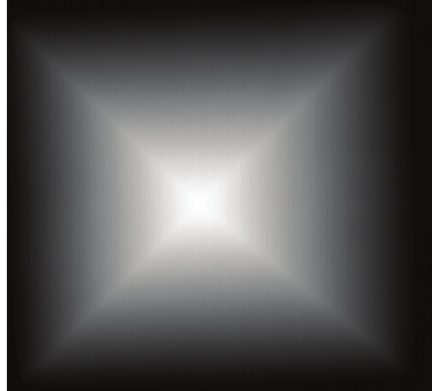
Figure 22: Unwrapped phase map.